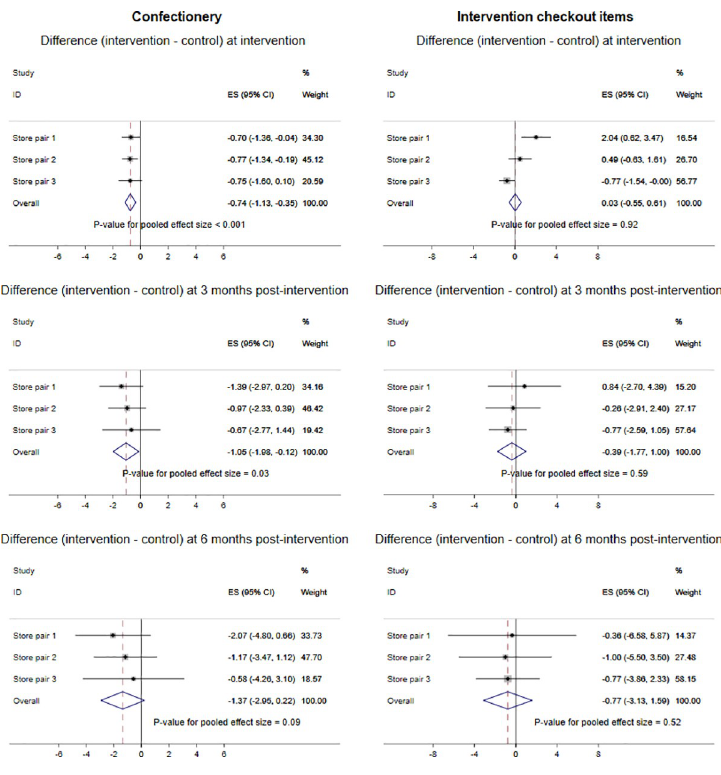
Fig 2. Meta-analysis of total sales of confectionery and intervention checkout items by store status.